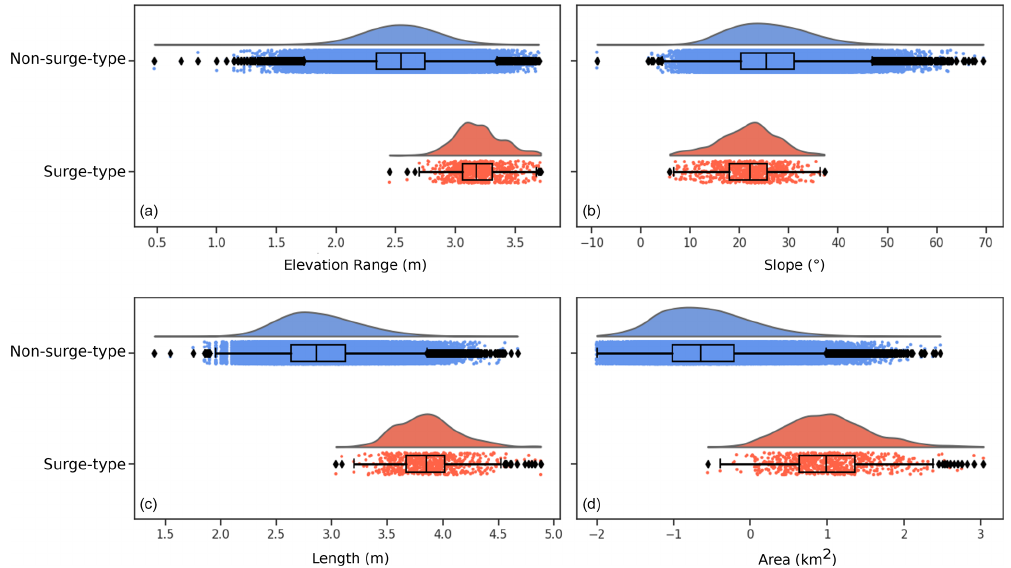
Figure 5. Distributions of geometrical attributes between non-surging and surge-type glaciers: (a) elevation range, (b) slope, (c) length and (d) area. Surge-type glaciers are represented in orange and non-surge-type glaciers in blue. L max is the length of the centreline of the longest glacier trunk of each RGI polygon. Area, length and altitude range are represented using common logarithms. Whiskers represent the 95th percentile of each distribution, while limits of the box represent 1 standard deviation.